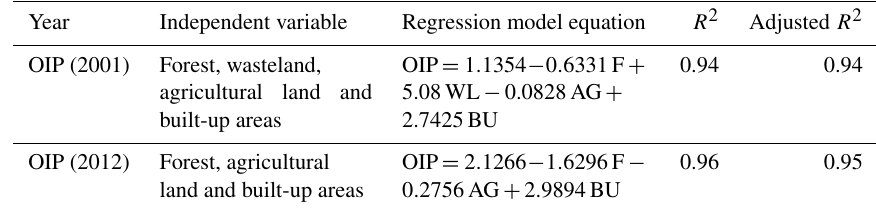
Table 11. Multiple linear regression models for OIP and LULC classes in the Upper Ganga River